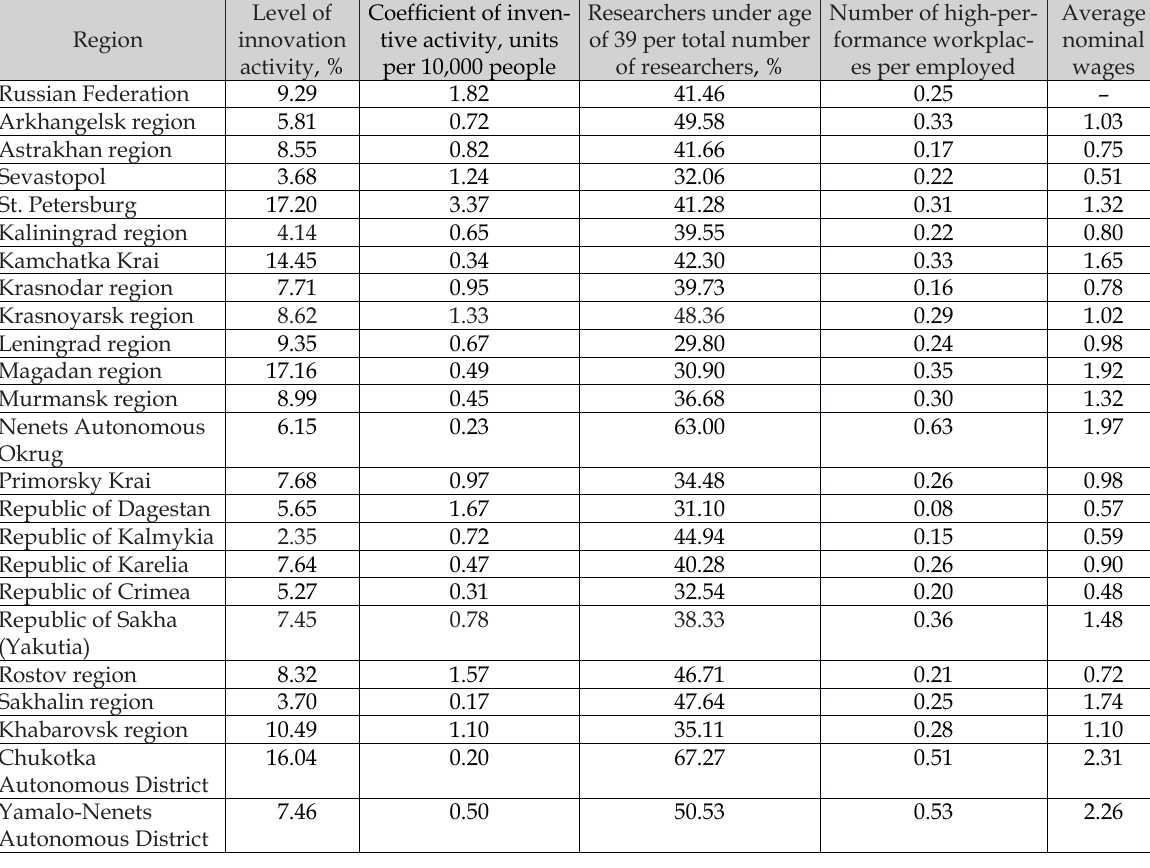
Table 4. Assessment of the coastal regions of Russia by some indicators of innovative attractiveness, 2011-2019.